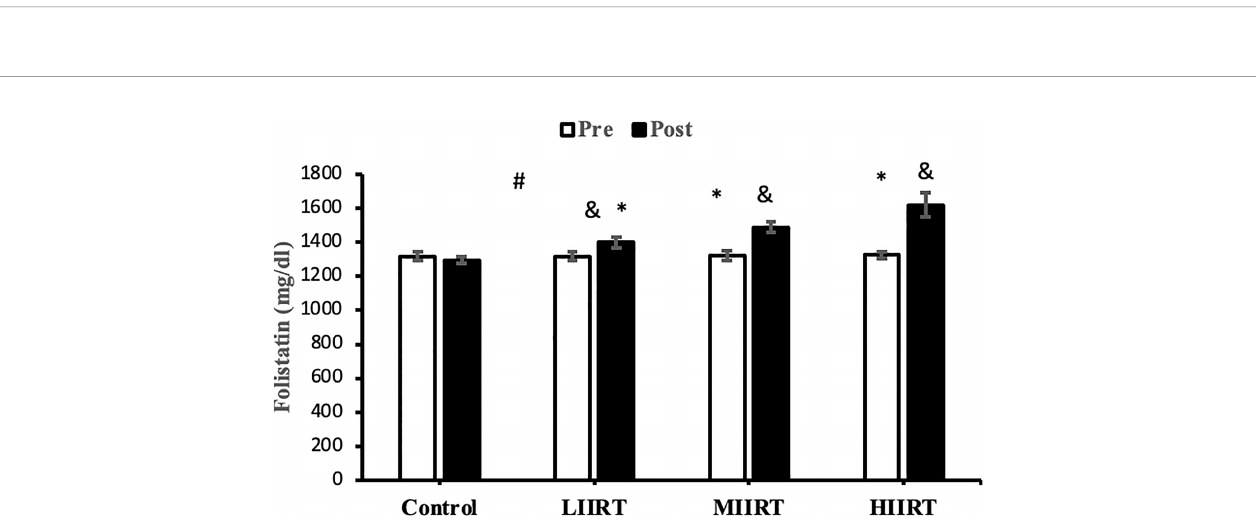
FIGURE 4 | Pre and post-training values (mean ± SD) for follistatin in control, low-intensity interval resistance training (LIIRT), moderate-intensity interval resistance training (MIIRT), high-intensity interval resistance training (HIIRT) groups. *Signi fi cant differences from the control group (p<0.05). & Signi fi cant differences from pretest values (p<0.05). # Signi fi cant differences between training